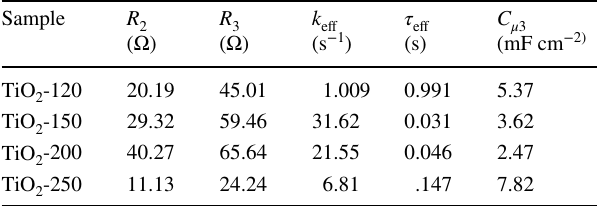
Table 4 EIS parameters of the dye-sensitized solar cells with mesoporous TiO 2 samples